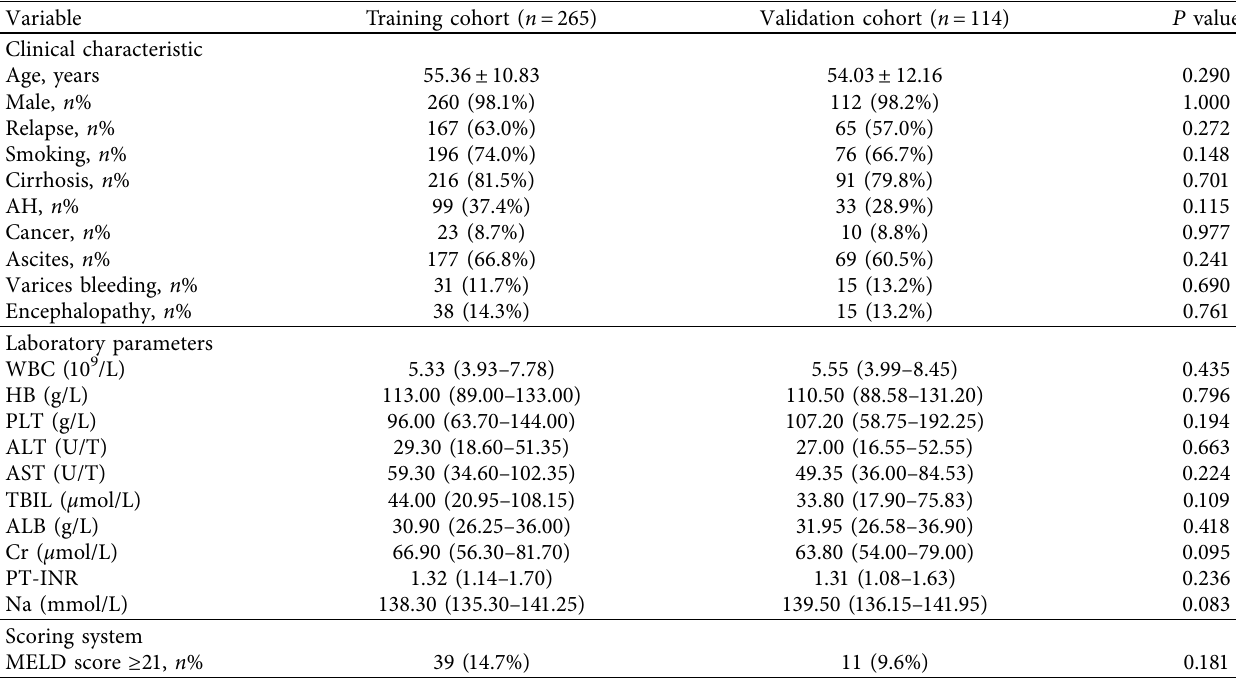
Table 1: Baseline characteristics of patients in different cohorts.